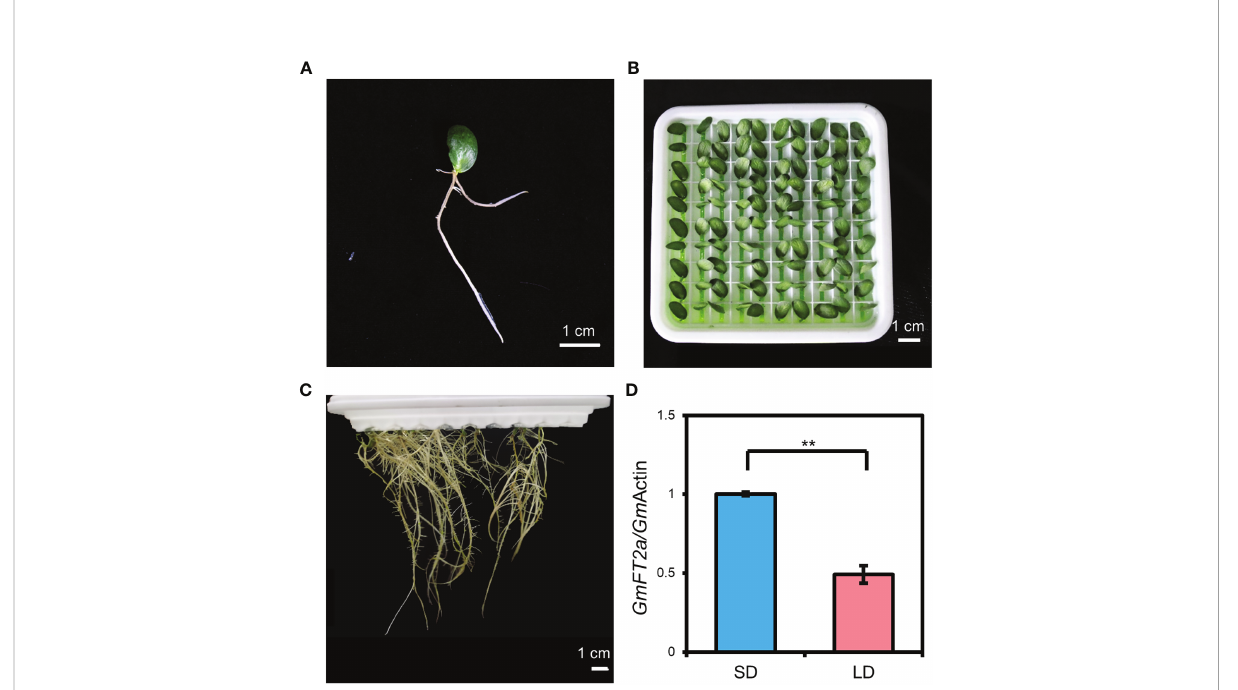
FIGURE 5 Generation of cotyledon-only plants (COPs) with only one cotyledon and root and their photoperiodic response. (A) One-week-old in vitro cotyledon with emerging root. (B , C) COPs with only one cotyledon and root under hydroponic culture: 4-d-old in (B) and two months old in (C) . (D) The expression level of GmFT2a in the cotyledons from one-week-old COPs with only one cotyledon and root through hydroponic culture under short-day (SD, 12 h light/12 h dark) and long-day (LD, 16 h light/8 h dark) conditions. The samples were harvested at 4 h after light on. Values represent the mean ± standard deviation from three biologically independent cotyledon samples from different plants. The reference gene is GmActin . Double asterisks indicate an extremely signi fi cant difference ( t -test, p value <